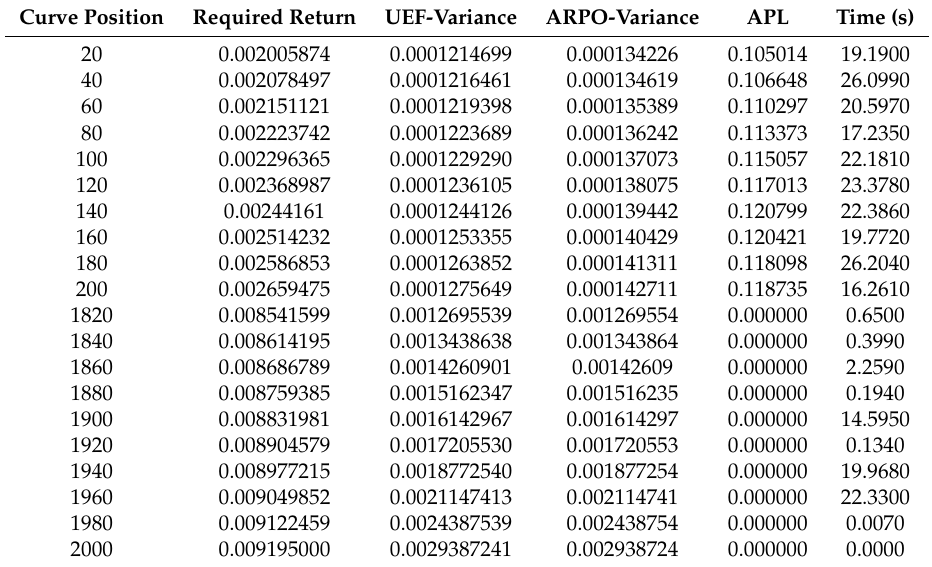
Table 5. S&P 100 Stock Market (United States).